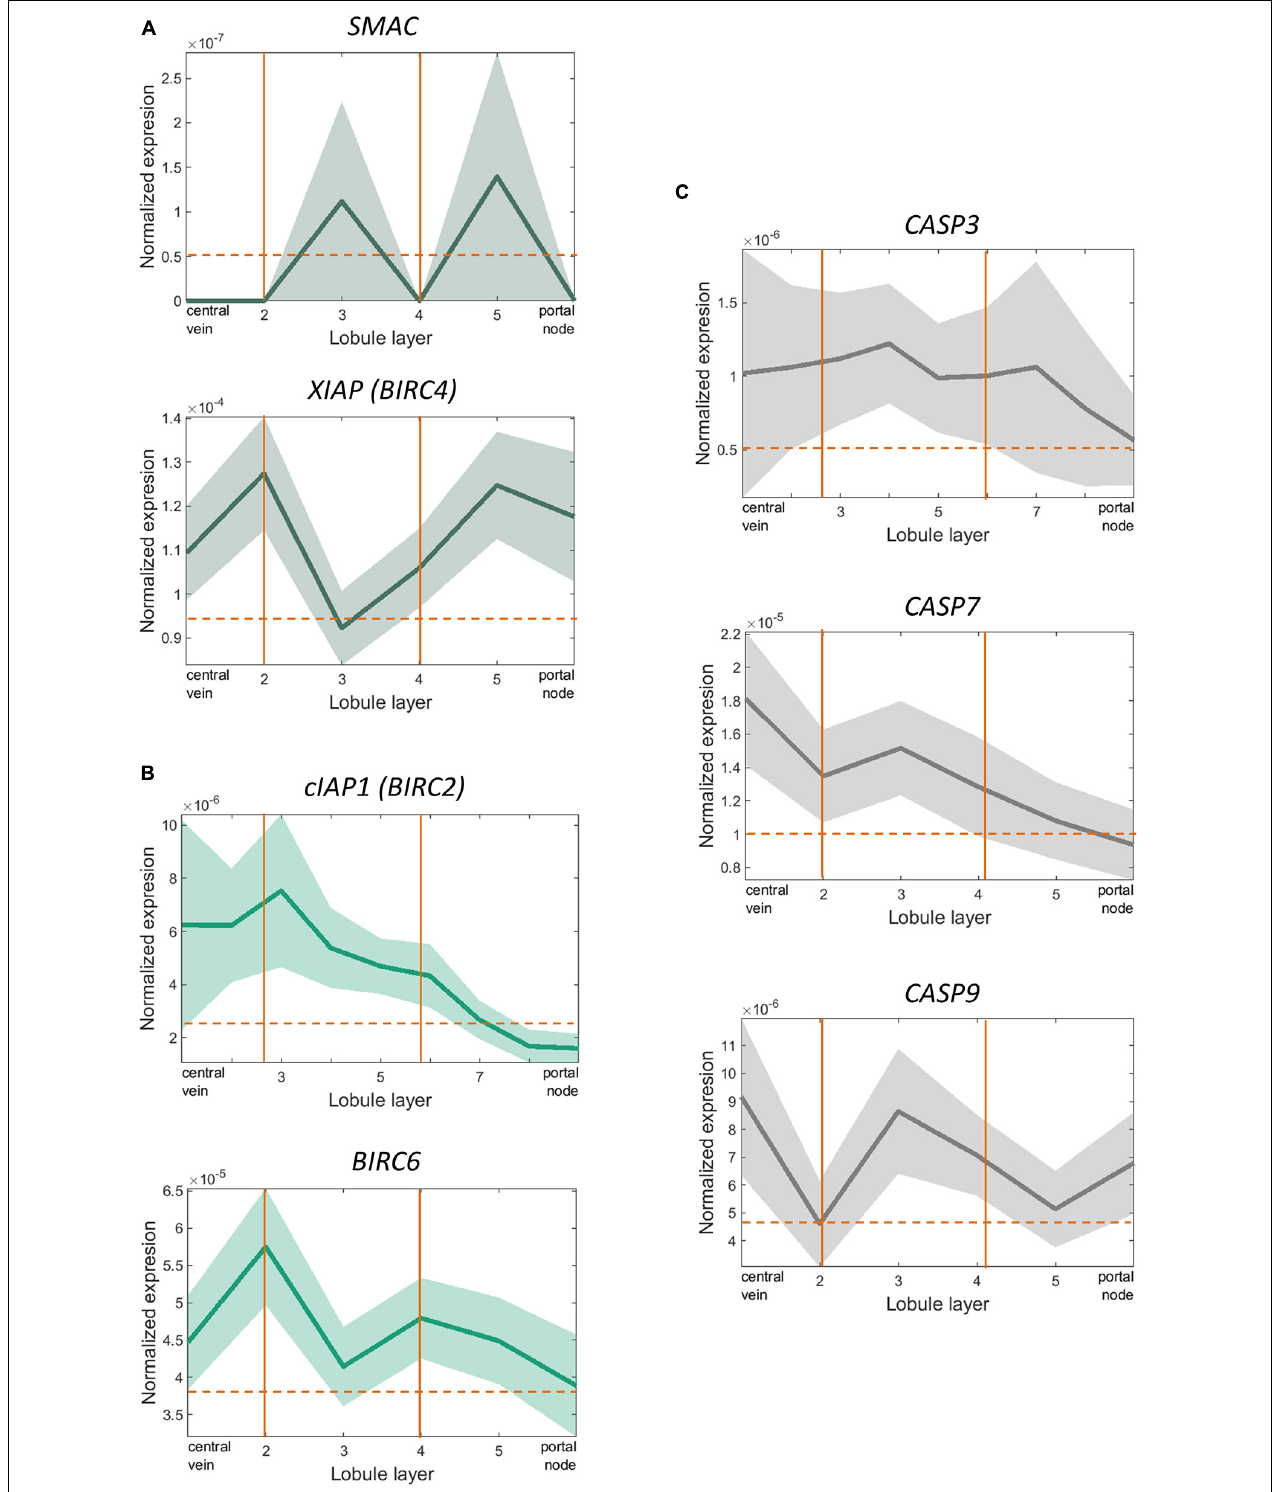
FIGURE 5 | scRNA-sequencing showed significant overlapping zonation of XIAP and SMAC genes in human liver tissue. (A) XIAP and SMAC expression levels varied from peri-portal to peri-central hepatocytes and were significantly zonated peri-portally. Their expression levels peaked in the same layer of hepatocytes ( p < 0.05). (B) cIAP1 ( BIRC2 ) and Apollon ( BIRC6 ) expression levels were zonated in the pericentral regions. (C) CASP3 , CASP7 , and CASP9 expression levels varied from peri-portal to peri-central hepatocytes and were significantly zonated in the peri-central regions. The expression pattern did not overlap with XIAP or SMAC .